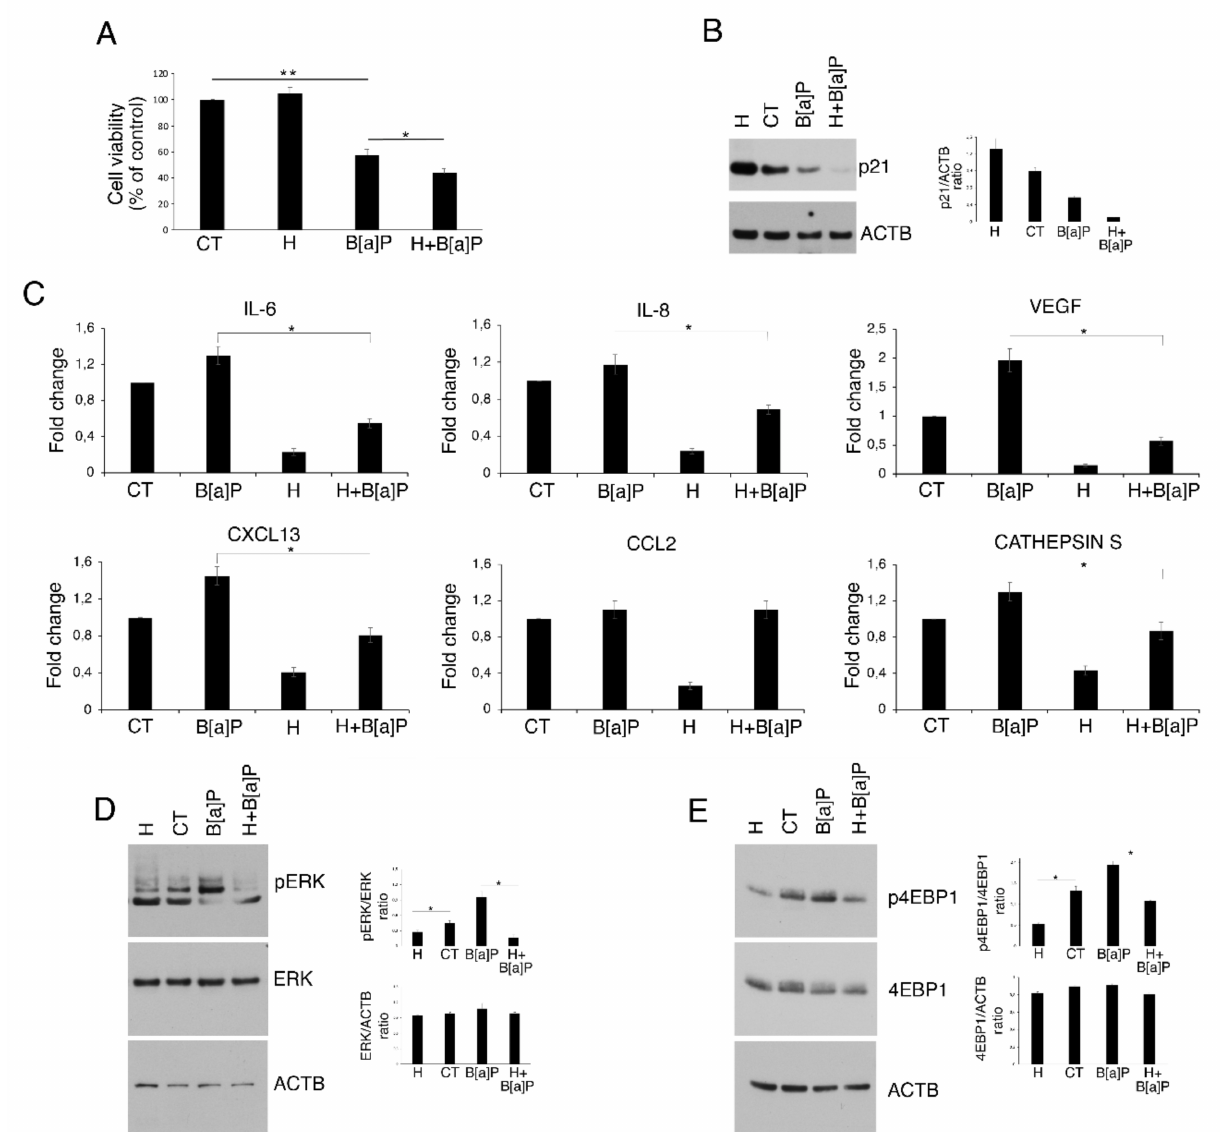
Figure 3. Hydroxytyrosol (H) slightly increases cell death while interferes with the pro-inflammatory milieu formation and ERK and mTOR activation induced by B[a]P treatment of HCoEpC. ( A ) % of cell viability of HCoEpC treated with H (1 µ M) and/or B[a]P (5 µ M) for 6 days. Mean ± standard deviation (SD) of three independent experiments is shown. (*) p < 0.05. ( B ) p21 level in HCoEpC treated with H (1 µ M) and/or B[a]P (5 µ M) for 6 days was assessed by Western blotting. ( C ) Fold change relative to control of IL-6, IL-8, VEGF, CXCL13, CCL2 and Cathepsin S released by HCoEpC treated with H (1 µ M) and/or B[a]P (5 µ M) for 6 days. Mean ± standard deviation (SD) of three independent experiments is shown. (*) p < 0.05. ( D ) Phospho-ERK 1/2 (pERK) and ( E ) phospho- 4EBP1 (p4EBP1) levels in HCoEpC treated with H (1 µ M) and/or B[a]P (5 µ M) for 6 days were analyzed by Western blotting. Actin (ACTB) was used as loading control and one representative experiment out of three is shown. Histograms represent the mean plus SD of the densitometric analysis of the ratio p21/ACTB, pERK/ERK, ERK/ACTB, p4EBP1/4EBP1 and 4EBP1/ACTB of three different experiments. (*) p < 0.05. Untreated cells were used as control (CT) in all the experiments in the